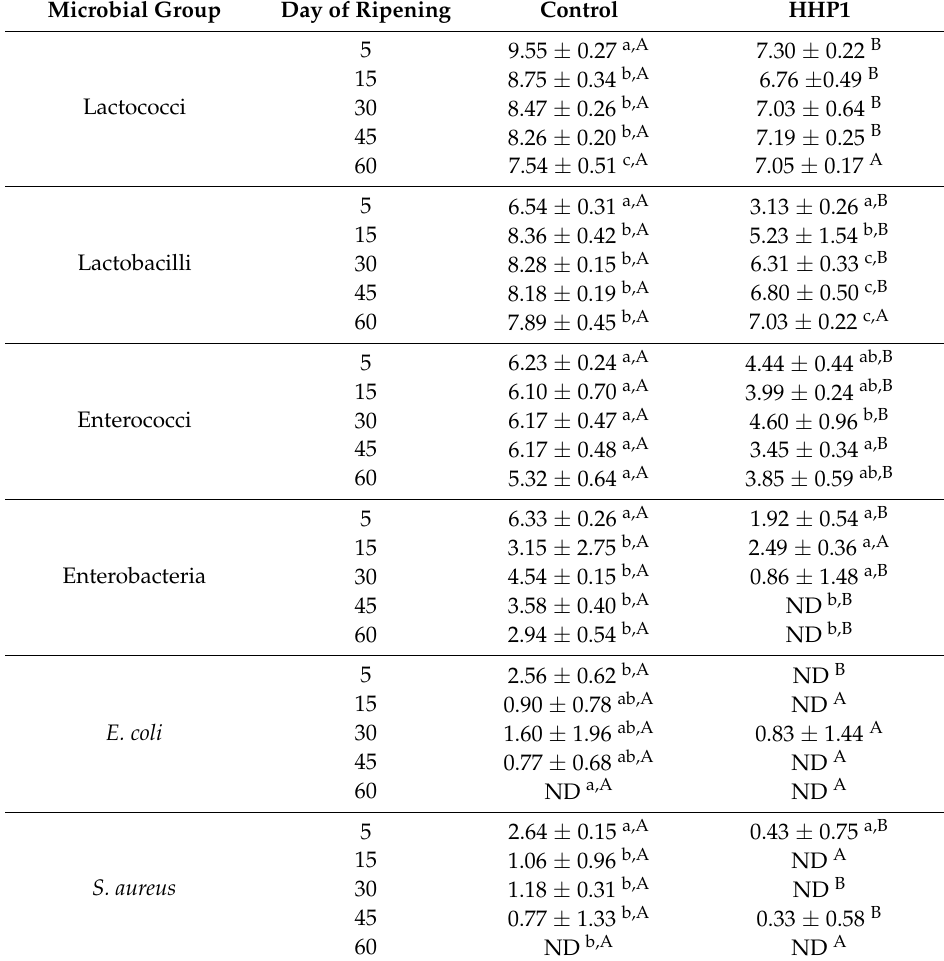
Table 1. Changes in microbial population (mean values ± standard deviation as log 10 CFU/g) of the goats’ raw milk cheese samples with and without high hydrostatic pressure (HHP) treatment during ripening.